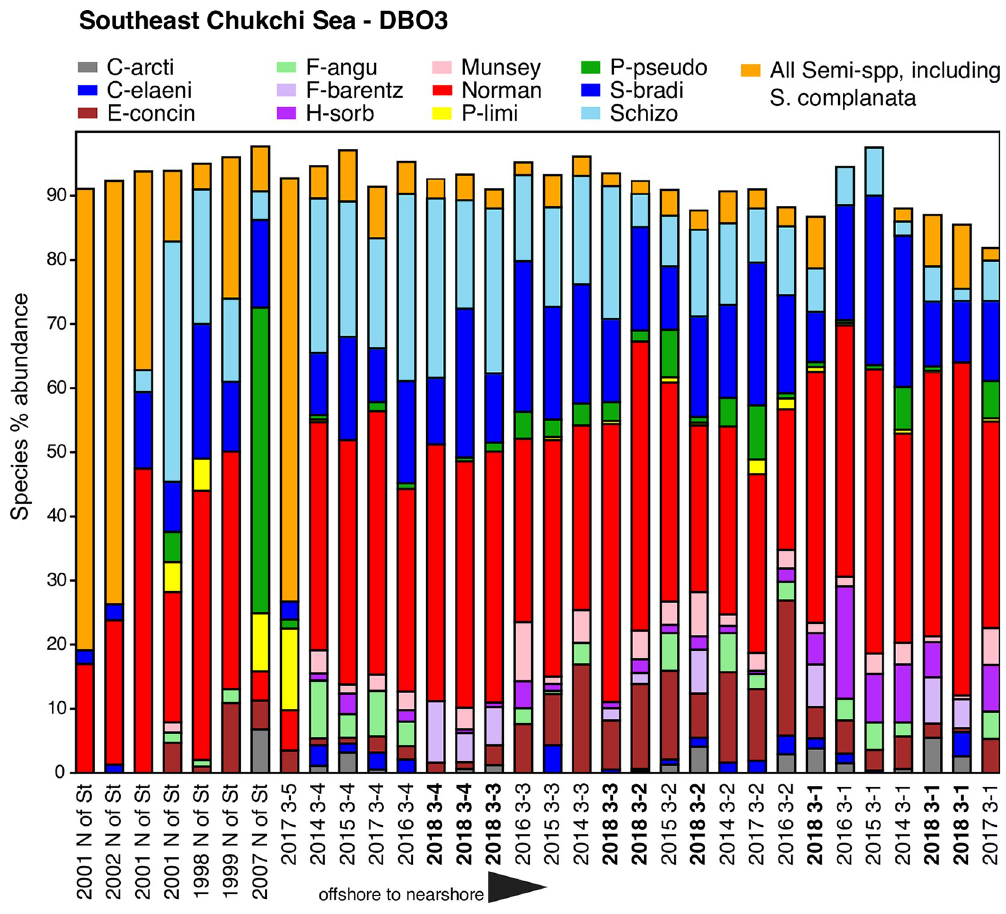
Fig 8. Primary species, DBO3—Southern Chukchi Sea. Stack plot of the 12 most abundant species and one genus ( Semicytherura ), comprising 92% of the ostracode assemblage, in DBO3 region (sites on Fig 2 map) from years ranging from 1998 to 2018, (n = 32 samples with � 30 specimens/sample, 7,514 total